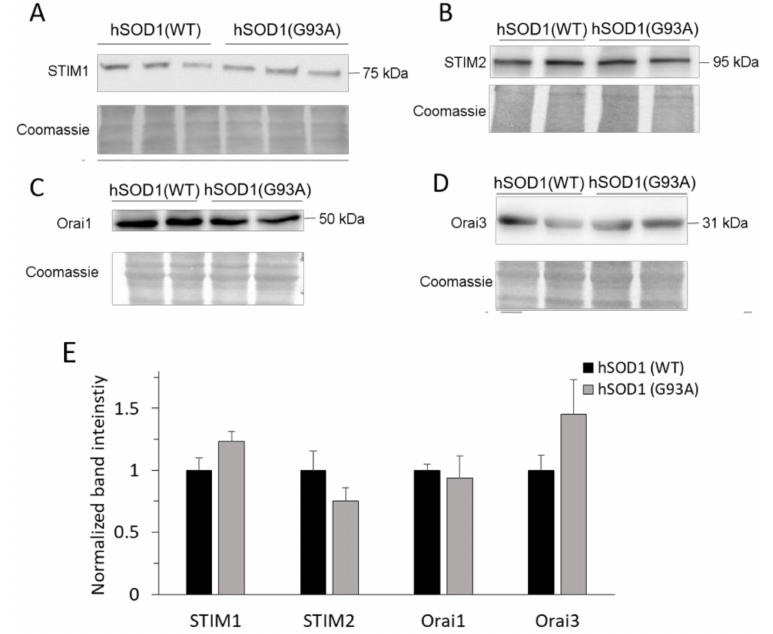
Figure 2. SOCE-regulating STIM and ORAI proteins are similarly expressed in primary astrocytes with the two hSOD1 genotypes. Proteins (18 µ g for each sample) from astrocyte lysates were resolved by SDS-PAGE, electroblotted onto polyvinylidene difluoride (PVDF) membranes, and analyzed by Western blot (WB) for the expression of proteins belonging to the SOCE machinery, i.e., STIM1 ( A ), STIM2 ( B ), Orai1 ( C ) and Orai3 ( D ), using suitable antibodies. In each panel, the upper figures report a representative WB of the protein of interest (run at least in duplicate), and the lower figures show the corresponding Coomassie blue-stained membrane. Molecular weights are reported on the right of each WB panel. The bar diagram of panel ( E ) reports the densitometric analysis of immunoreactive bands for the di ff erent proteins normalized to the optical density of the corresponding Coomassie blue-stained lane. Densitometric data are reported as fraction of the mean value obtained with hSOD1(WT) cells. No significant di ff erence (unpaired two-tailed Student’s t -test) exists for any of the analyzed proteins between hSOD1(WT) and hSOD1(G93A) astrocytes. n = 6 di ff erent biological replicates (i.e., di ff erent primary cultures) for each hSOD1 genotype and each target protein. Full-size images of WBs are reported in Figures